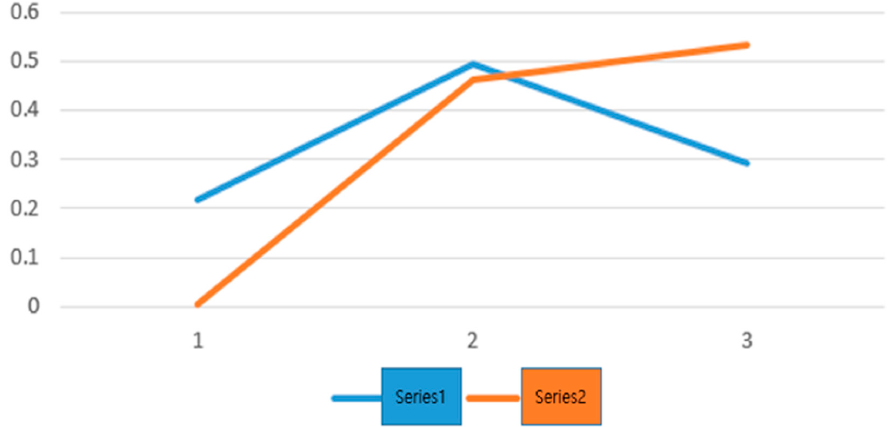
Figure 23. Comparison between the appearance frequency of “mosquito” and maximum power. (“Living Culture” section of Naver news, 2018).